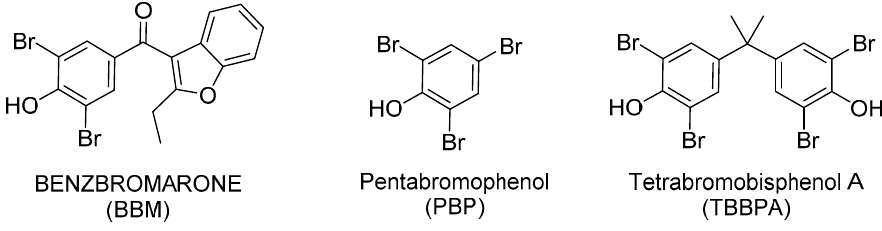
Scheme 2. Chemical structures of the small-molecule compounds sharing a dibromophenol scaffold: